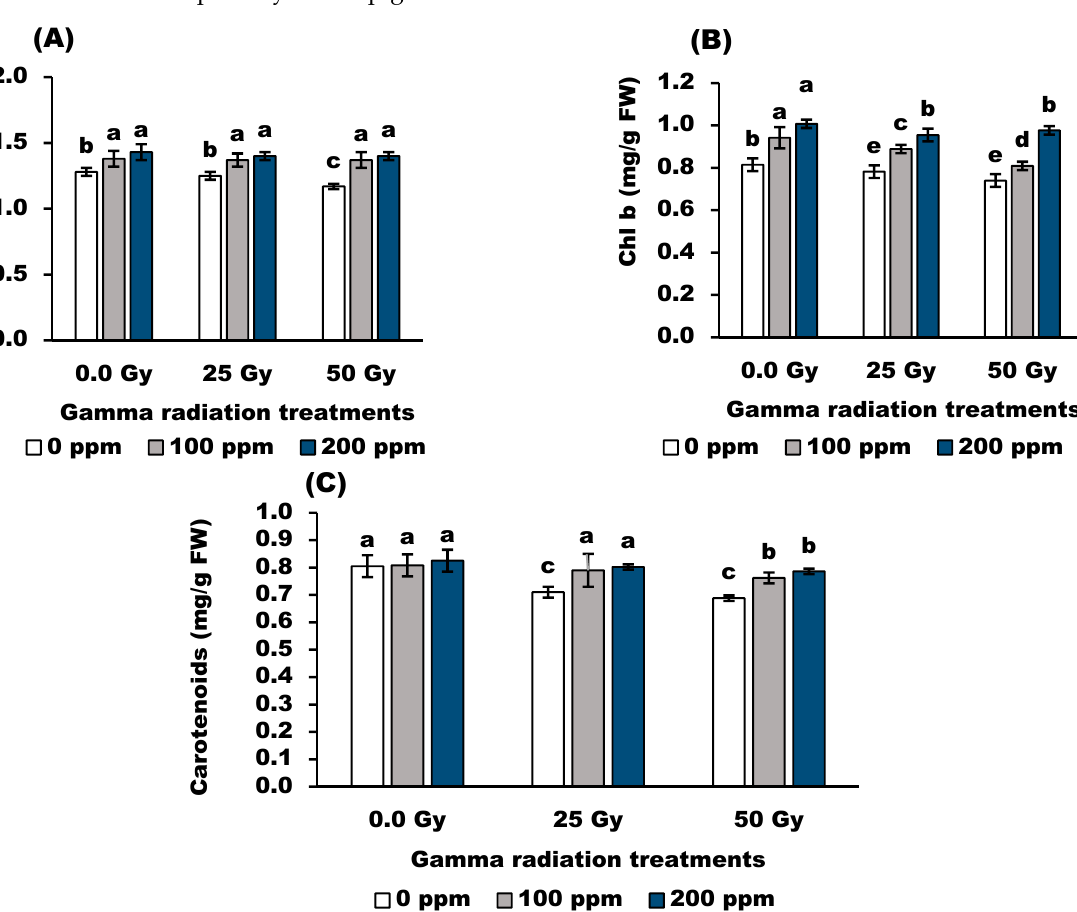
Figure 1. Effect of stigmasterol treatments on photosynthetic pigment; ( A ) Chl a , ( B ) Chl b , and ( C ) carotenoids contents of wheat plants grown from grain irradiated with gamma rays. The different letters (a–e) show statistical significance at p < 0.05; vertical bars indicate ± SD.